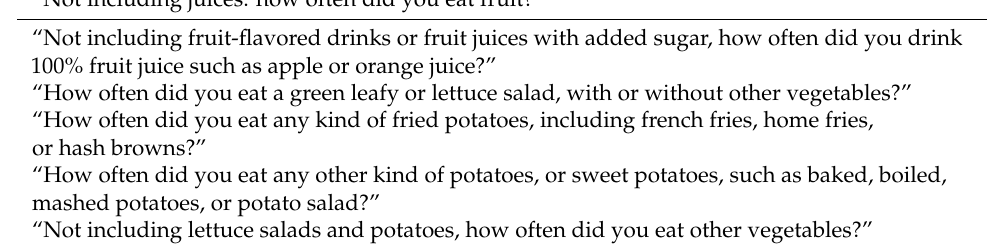
Table 1. BRFSS Nutritional Intake